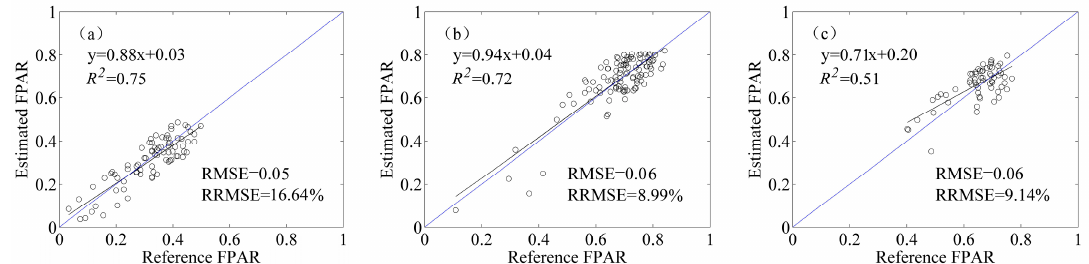
Figure 13. Comparison between the Copernicus FPAR and our estimated FPAR: ( a ) In mid-March; ( b ) In mid-April; and ( c ) In mid-May.